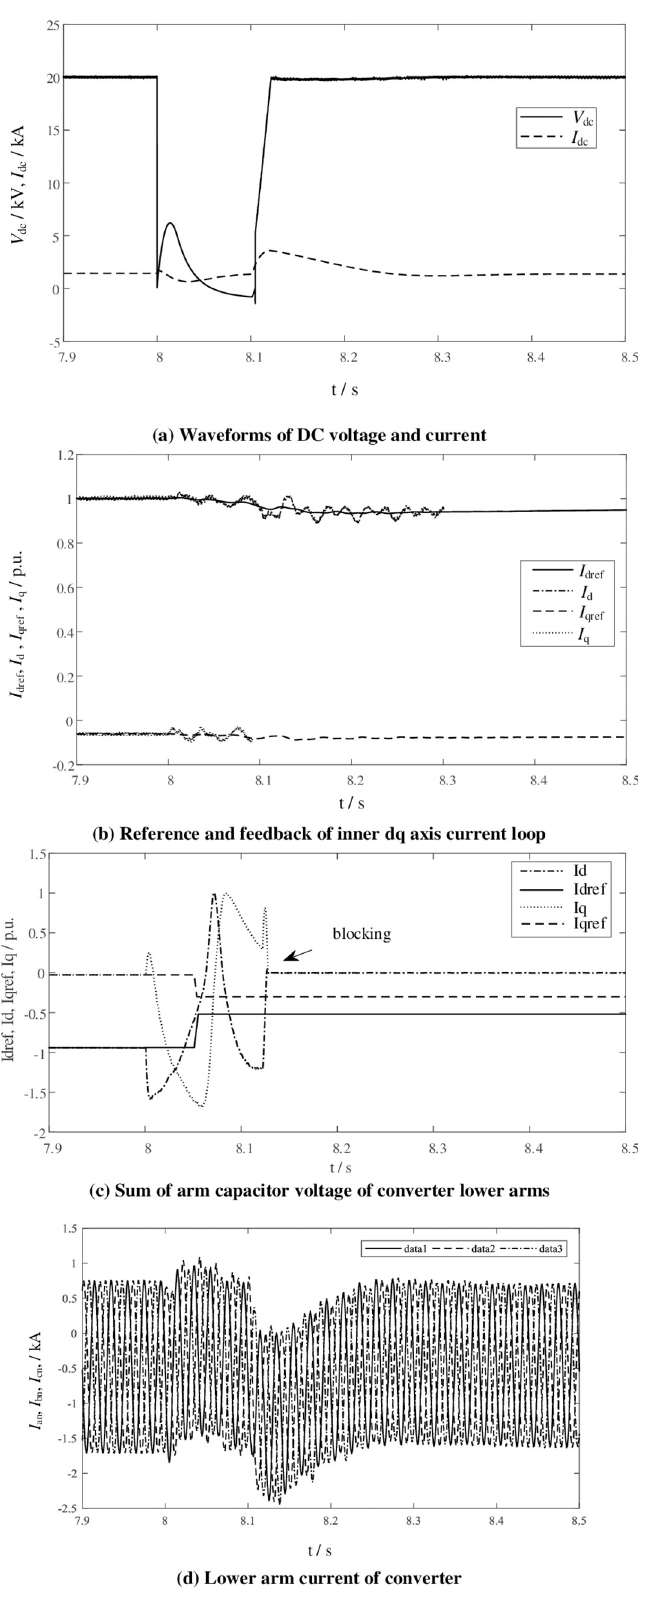
Fig 11. DC short-circuit fault simulation waveform. https://doi.org/10.1371/journal.pone.0277553.g011 PLOS ONE | https://doi.org/10.1371/journal.pone.0277553 December9,